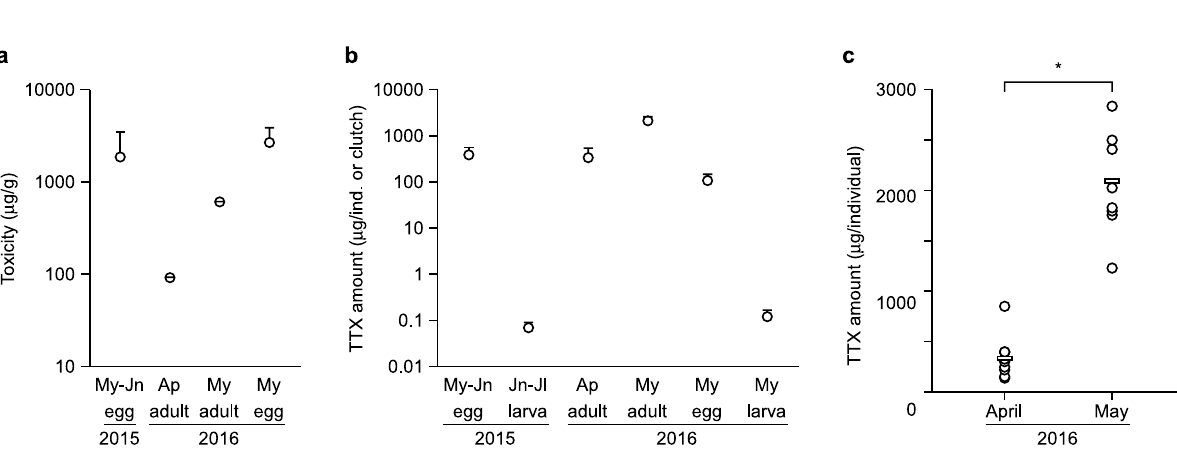
Figure 2. Detection of Planocera multitentaculata in the intestinal contents of young wild Takifugu niphobles individuals ( a ) and TTX content (mg/individuals) in the pufferfish individuals ( b ). The arrow indicates PCR products specific to P. multitentaculata . Lane M: molecular weight marker; lane A: anterior part of the intestine; lane C: middle part of the intestine; lane P, posterior part of the intestine; lane PC, positive control ( P. multitentaculata ). P. multitentaculata -specific band is present in No. 3 and 5 individuals. Full-length gel is included in a Supplementary Information file (Fig. S4).